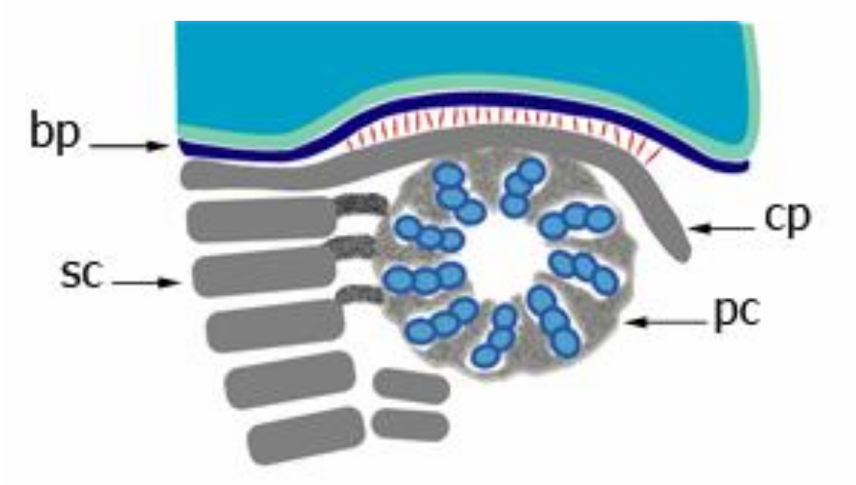
Figure 3. Schematic depiction of the developing connecting piece. Transverse section of the proximal centriole demonstrating the continuity of the dense material located in the space between the centriolar triplets with the future capitulum. This dense material fuses with the striated columns forming the capitulum. The capitulum is linked to the basal plate via thin fibers (in red). The basal plate is a local thickening of the nuclear envelope in the implantation fossa. bp basal plate, sc segmented columns, cp capitulum, pc proximal